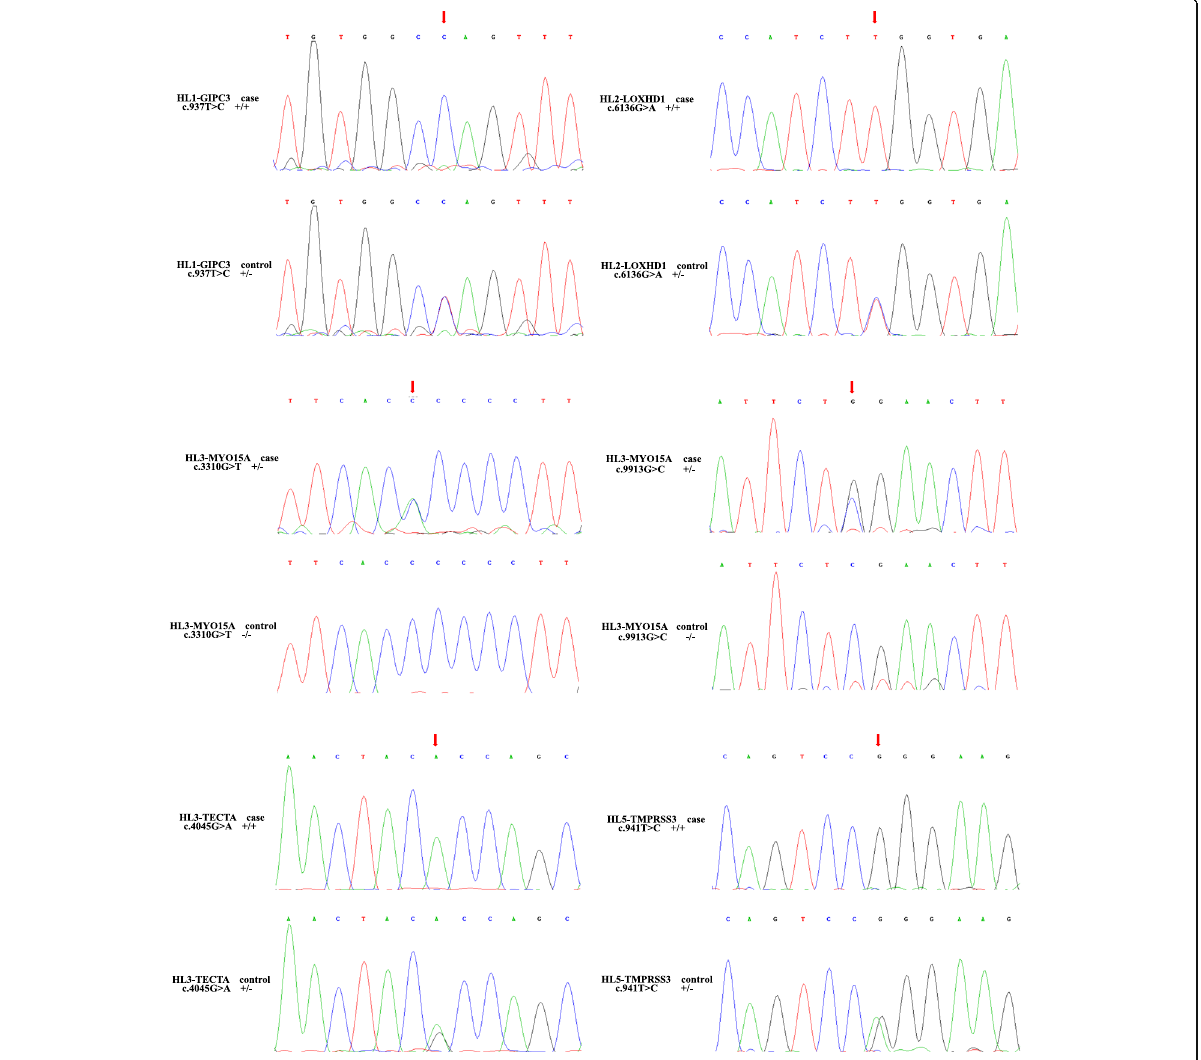
Fig. 2 Sanger results of the candidate variants. The 6 variants are shown. Each variant contains a case and a control in the family. The Sanger result of the case is on the top, while the Sanger result of the control is on the bottom. The red arrow indicates the variant